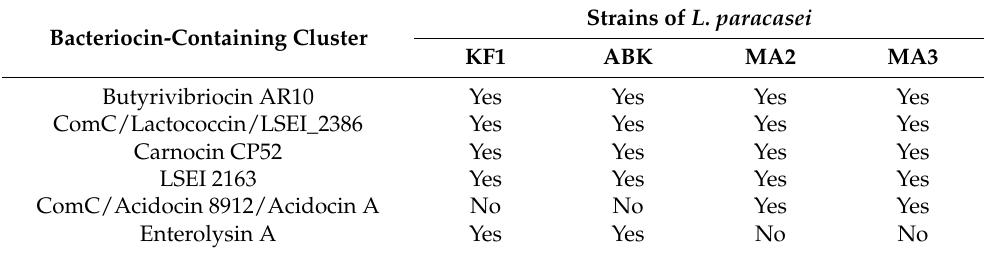
Table 4. Data on the bacteriocin genome content of the kefir-derived (KF1 and ABK) and mahewu- derived (MA2 and MA3) strains of L. paracasei